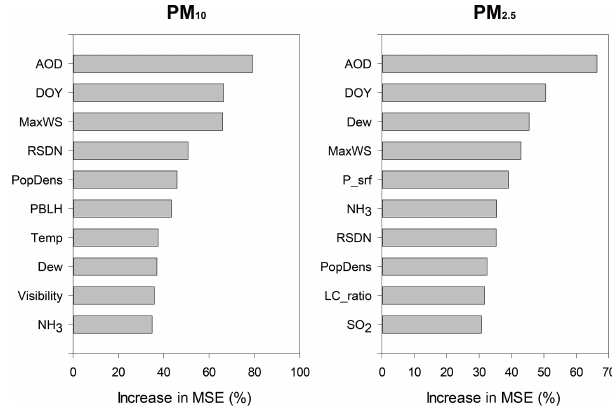
Figure 4. Variable importance of the top 10 input variables identi- fied by the random forest models for estimating ground-level PM 10 and PM 2 . 5